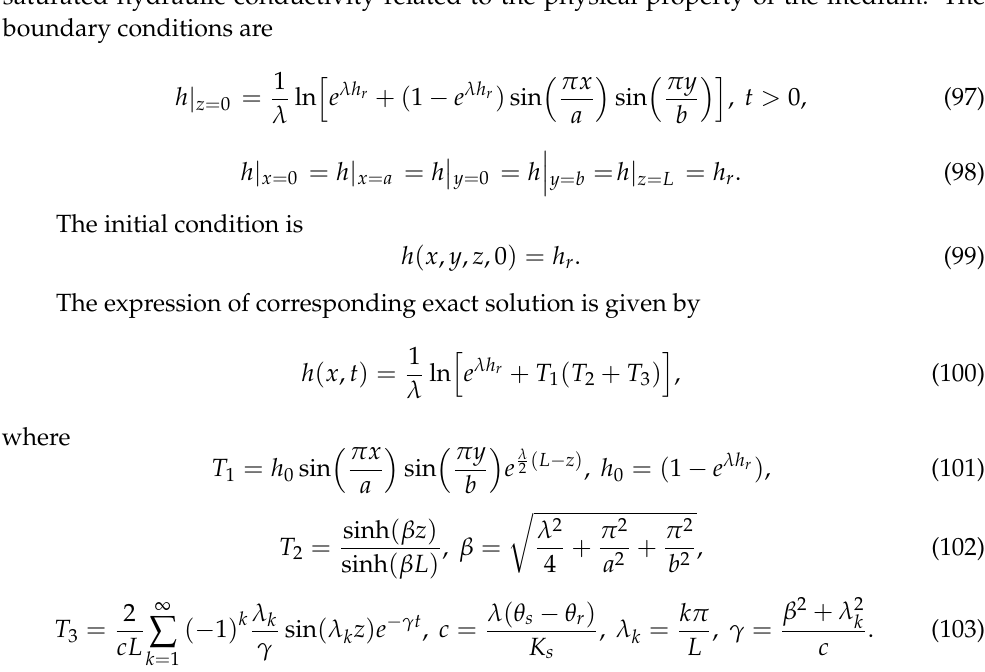
Figure 12. Calculation results on layers / 10, k z = ( 0,1, ,10) k